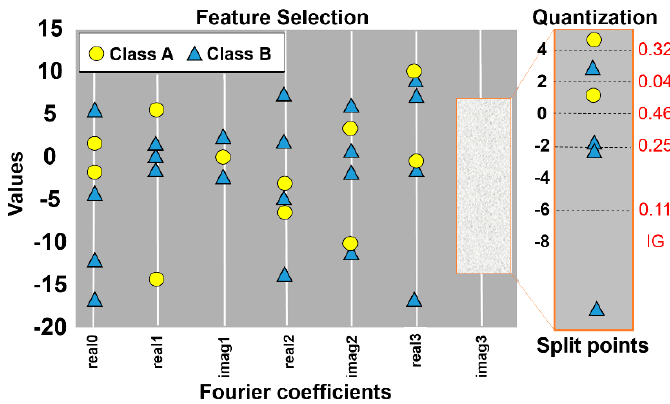
Figure 14. Example of how the SFA-W discretization process works. In this example, two classes are used ‘A’ and ‘B’, with the real0 and imag3 coefficients selected as the best. Then, the best cut-off point was 0.46.